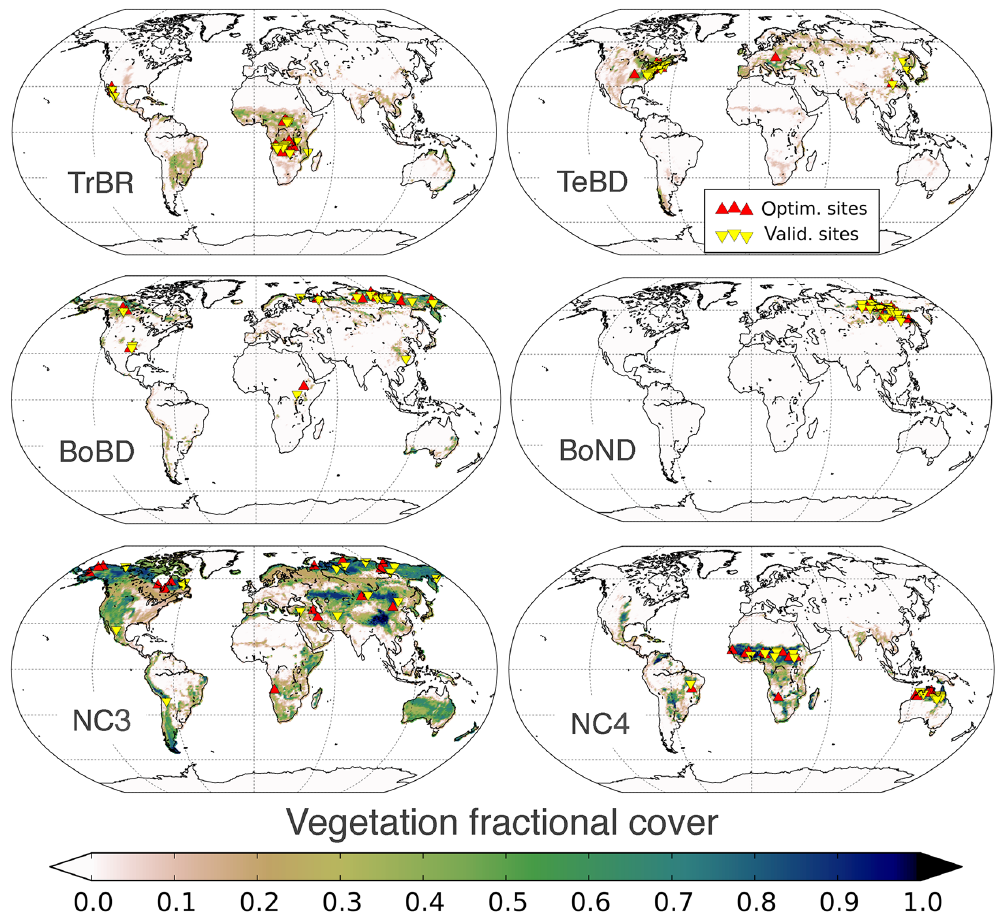
Figure 2. Global distributions of fractional cover for the six PFTs optimised in this study. Red upright triangles mark the location of the optimisation sites, and yellow upside-down triangles mark the location of the validation